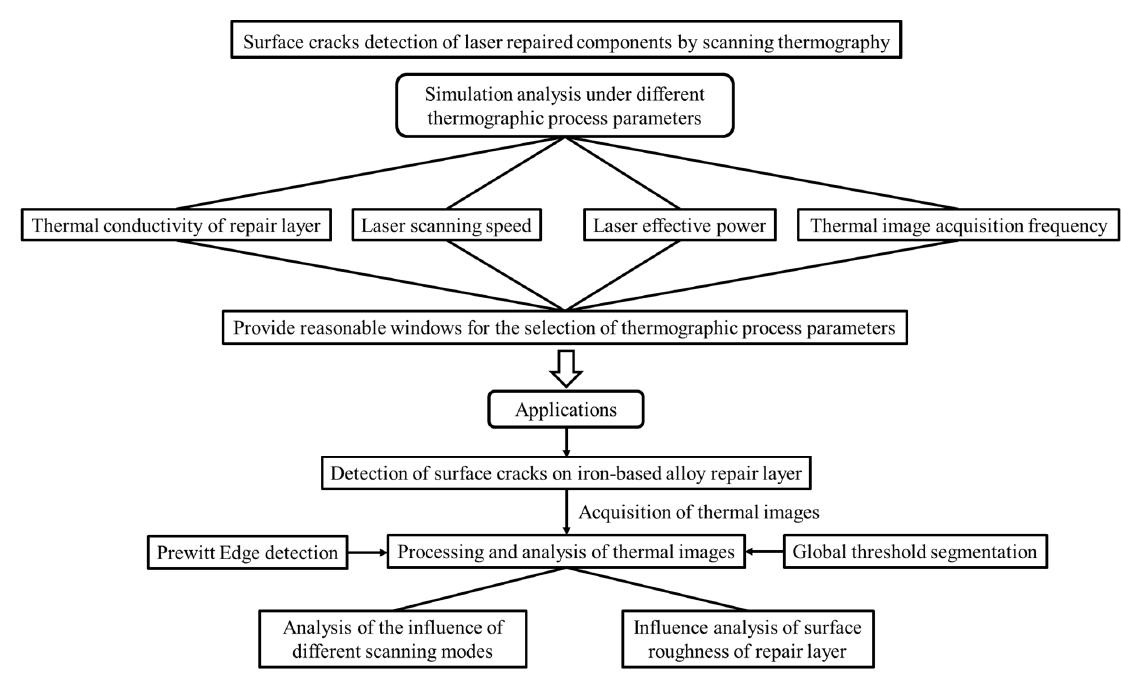
Figure 1. The research framework and technical route.